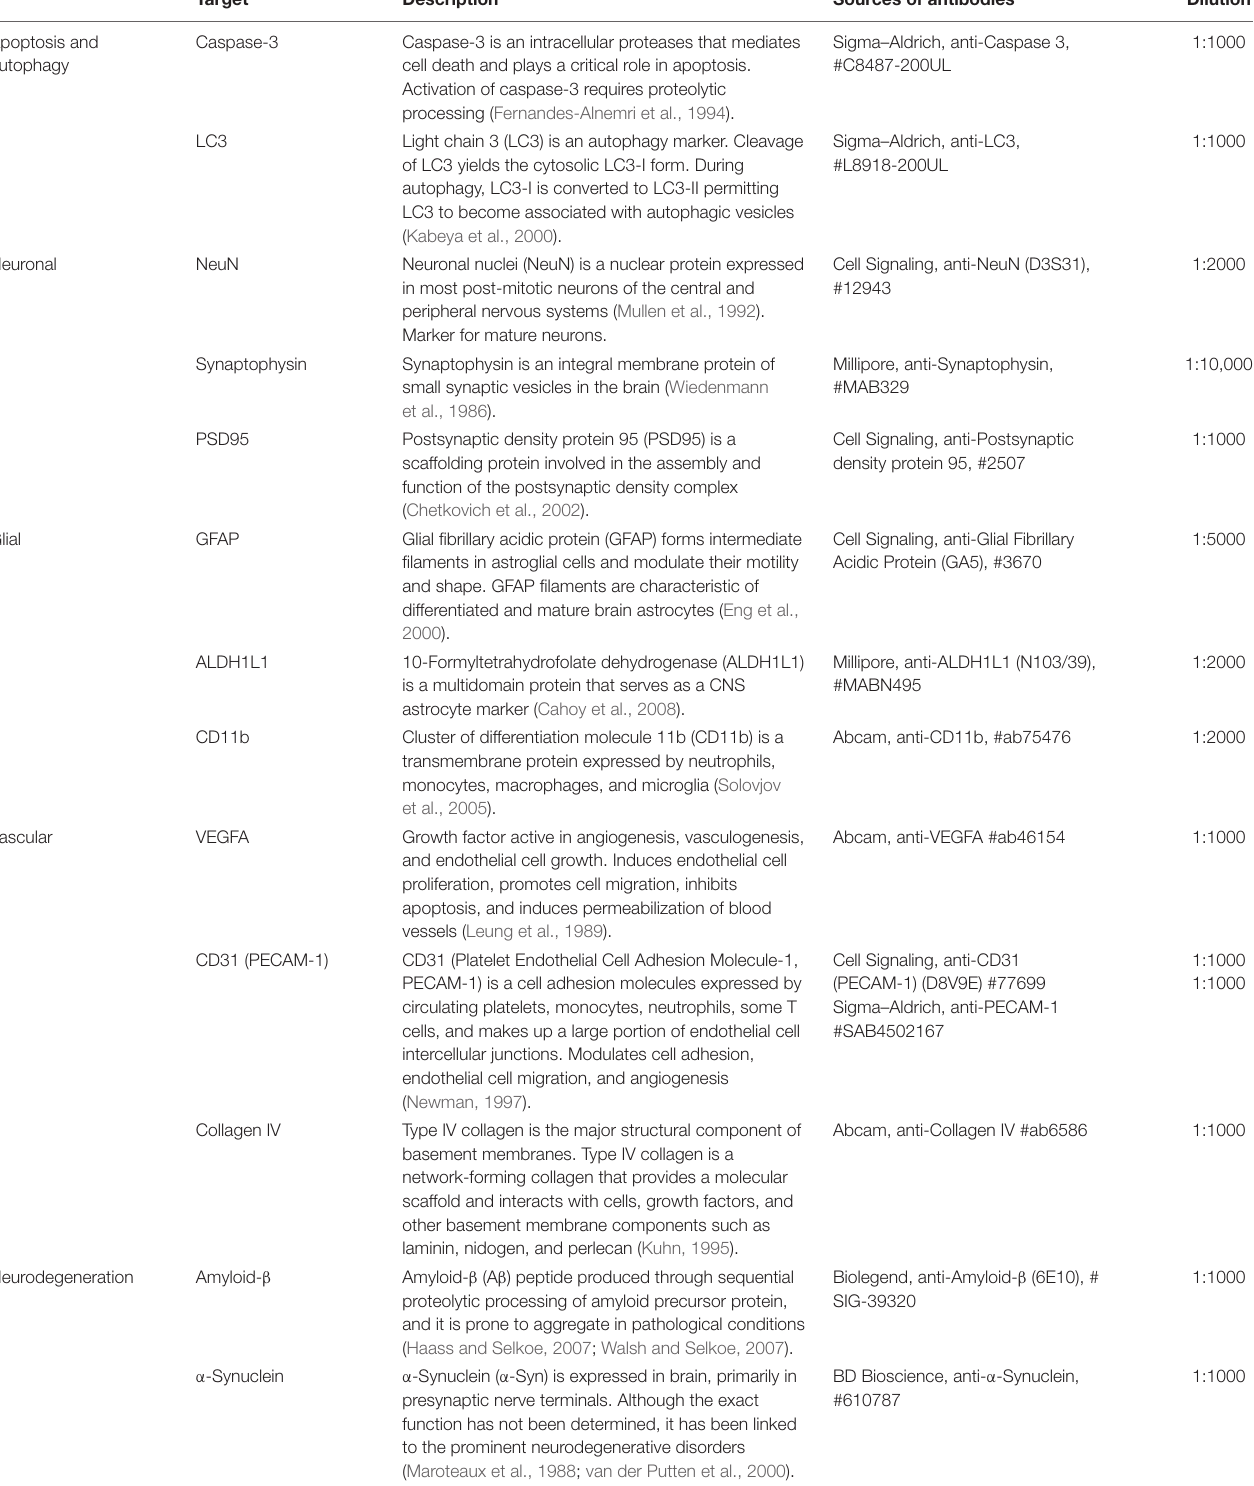
TABLE 1 | List of antibodies used for western